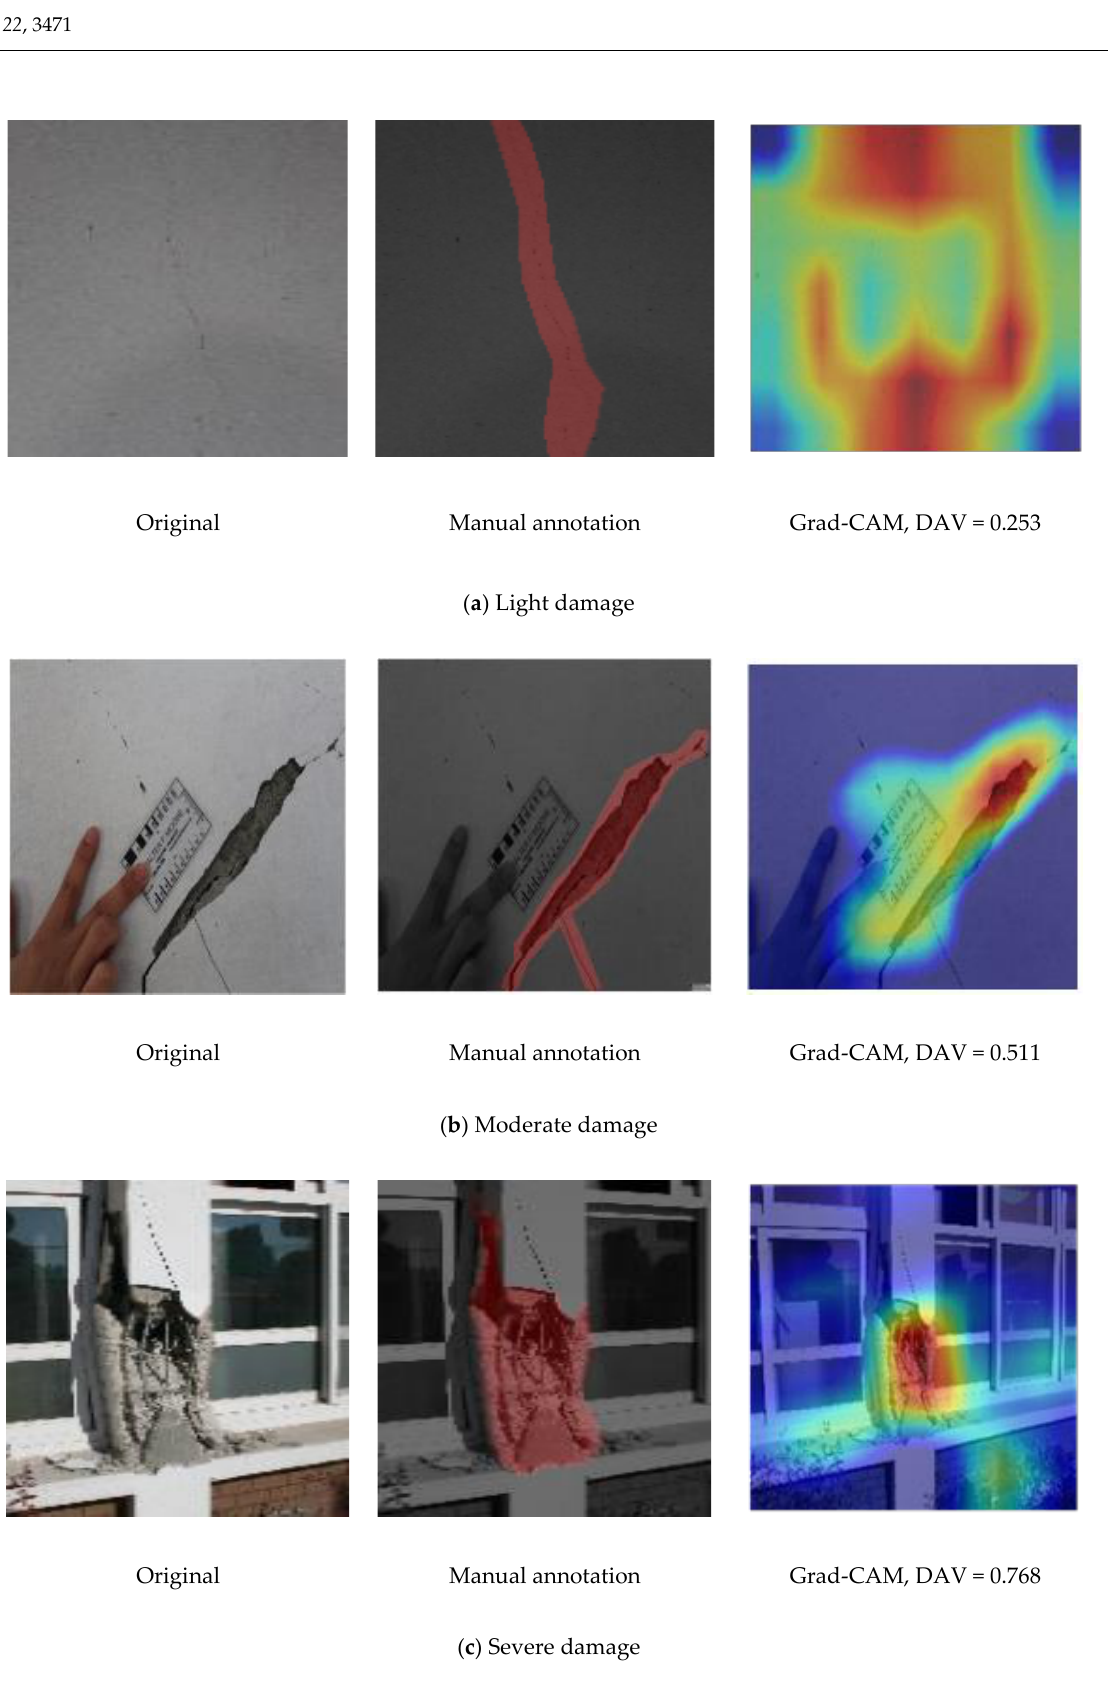
Figure 13. Sample images with annotations for severity and corresponding damage assessment value (DAV) scores for images of ( a ) light damage, ( b ) moderate damage, and ( c ) severe